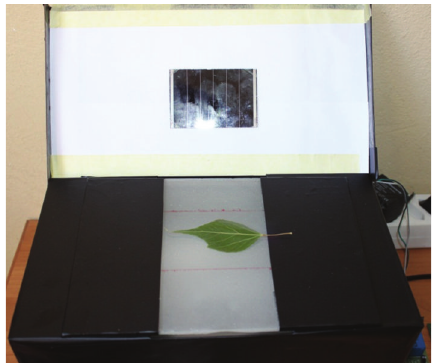
Figure 3: The layout of the opal glass used for diffusing the parallel reflected